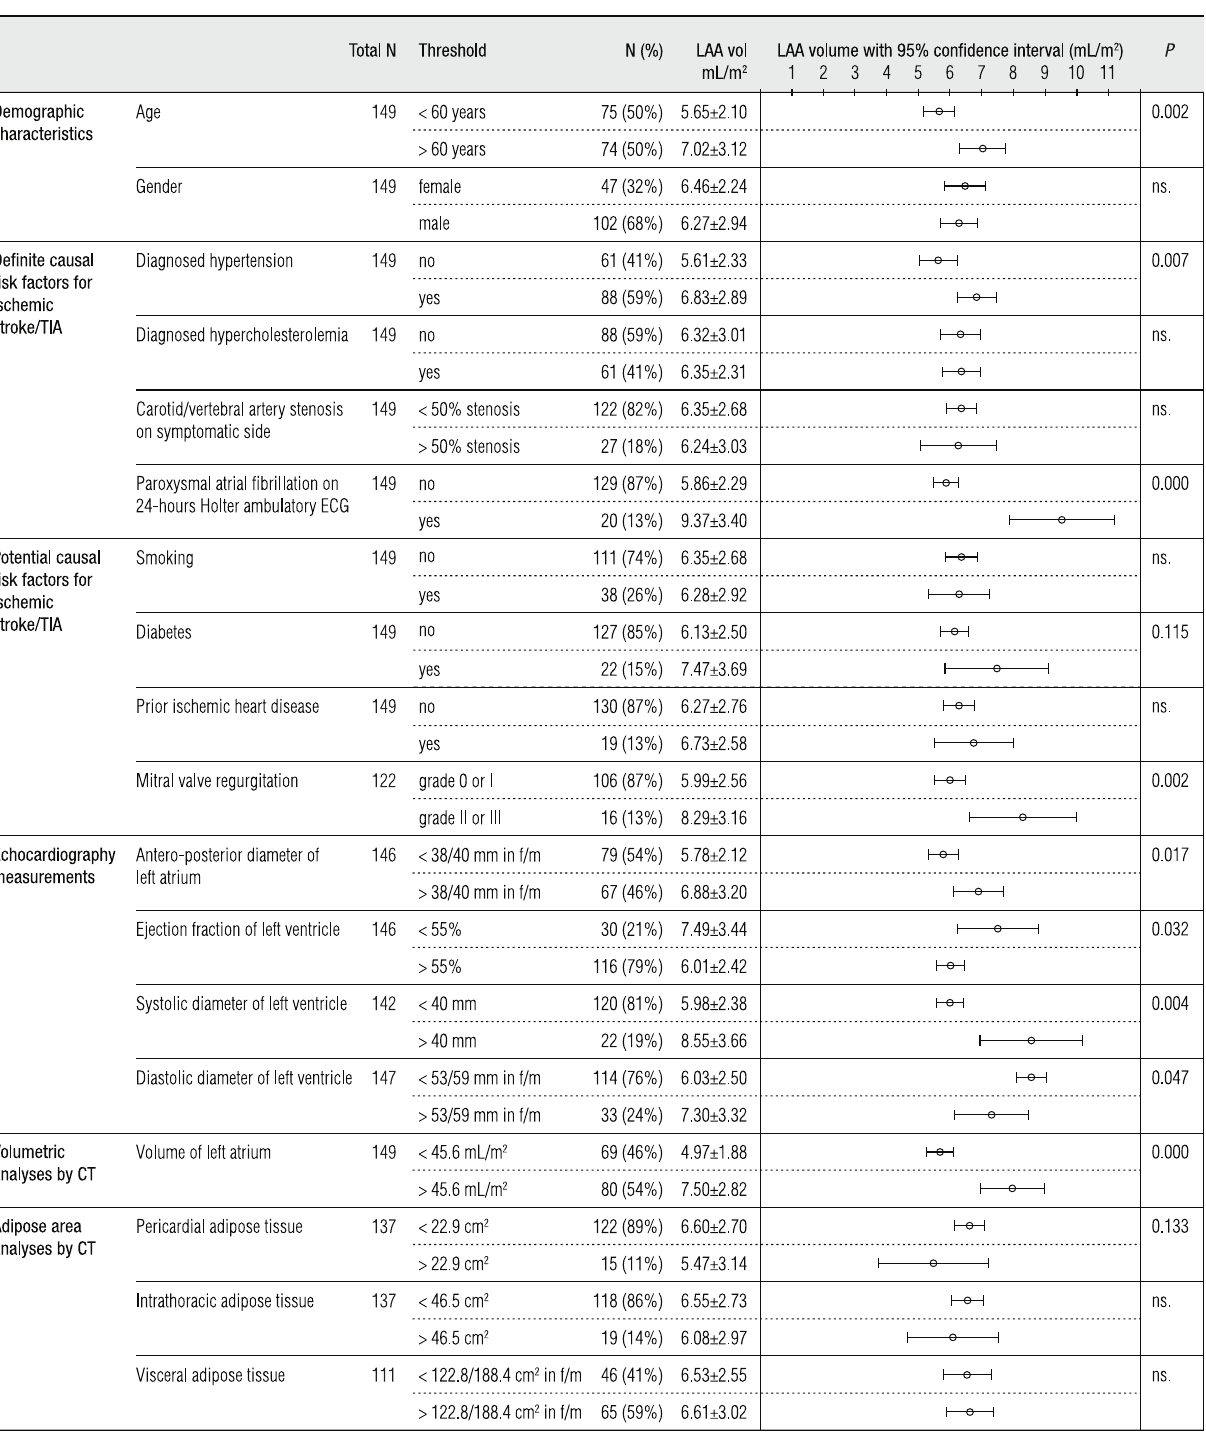
Figure 1. The left atrial appendage (LAA) volume was measured in 149 cardiogenic stroke/TIA patients without chronic atrial fibrillation. There were 18 different variables to determine factors that increase LAA volume. Patients were dichotomized by the measurements performed with transthoracic echocardiography following the guidelines of the American Society of Echocardiography (ASE) [23] and computed tomography (CT) by using the threshold values that were based on normal variations in reference populations [5,24]. Numbers (N) and percentages (%) of the patients’ mean LAA volumes adjusted for patient’s body surface area with standard deviation in dichotomized groups are presented. LAA volumes with 95% confidence interval in every group are shown. Variables with statistical significance ( P ) , 0.2 were included for stepwise linear regression analyses. Vol=volume; f=female; m=male.